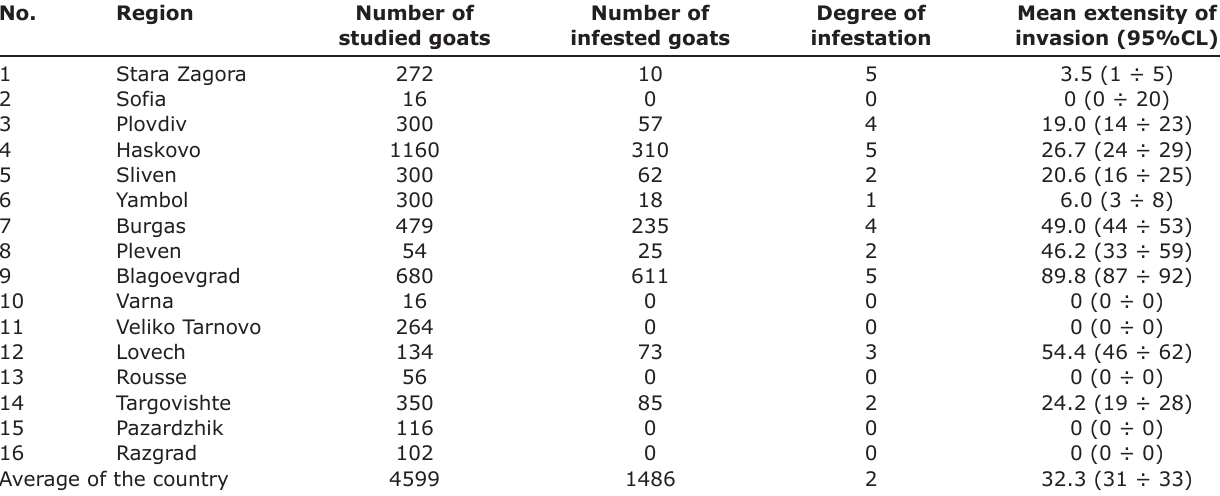
Table-6: Regional distribution of the degree of infestation and mean extensity of invasion with P. irritans in domestic goats. No. Region Number of studied